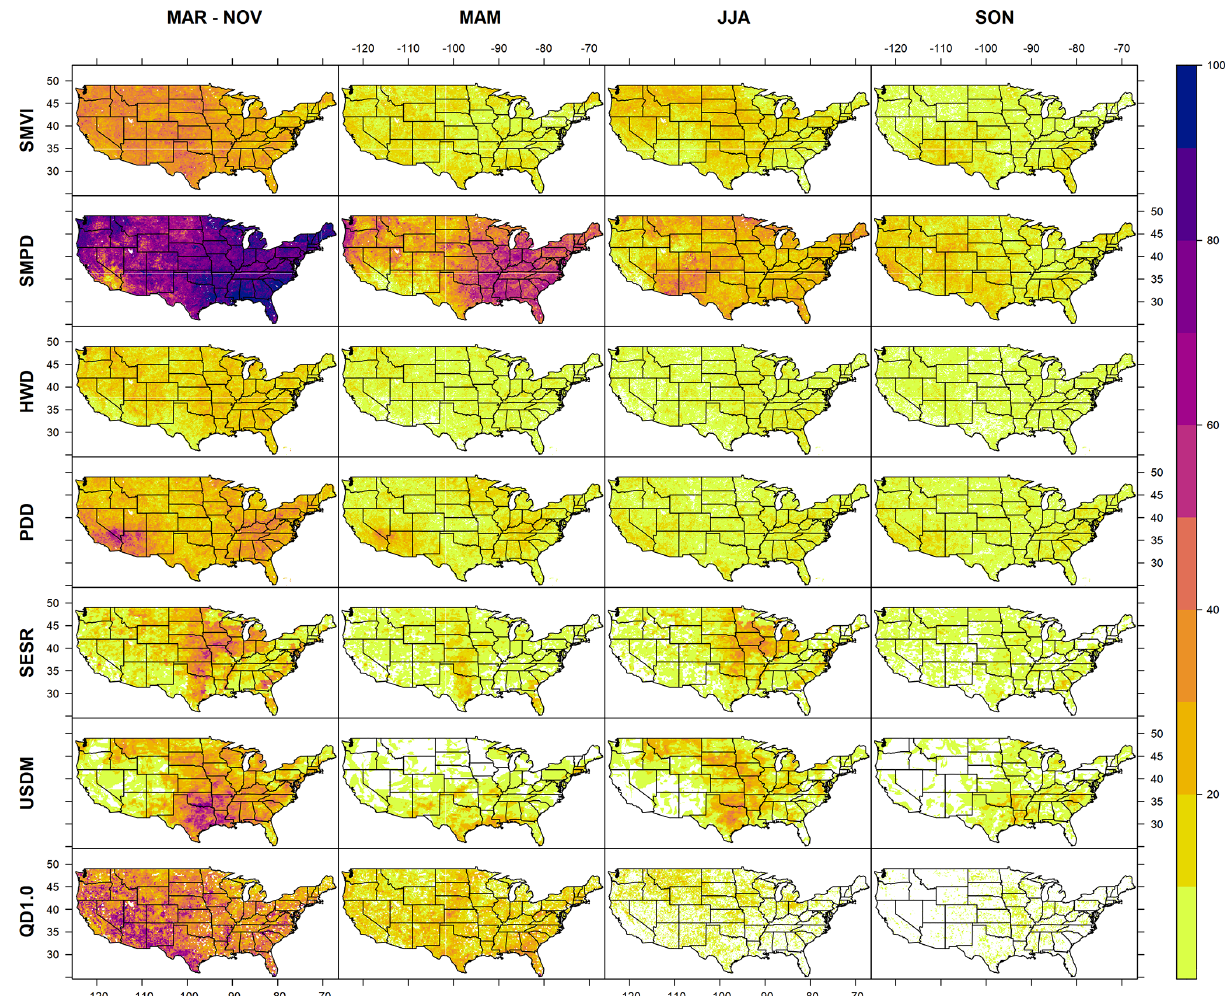
Figure 4. Flash drought onset frequency for the selected definitions, calculated for the period of available data for each definition through 2018 (1979–2018 for SMVI, SMPD, HWD, PDD, and SESR; 2000–2018 for USDM and QD1.0). White color represents zero